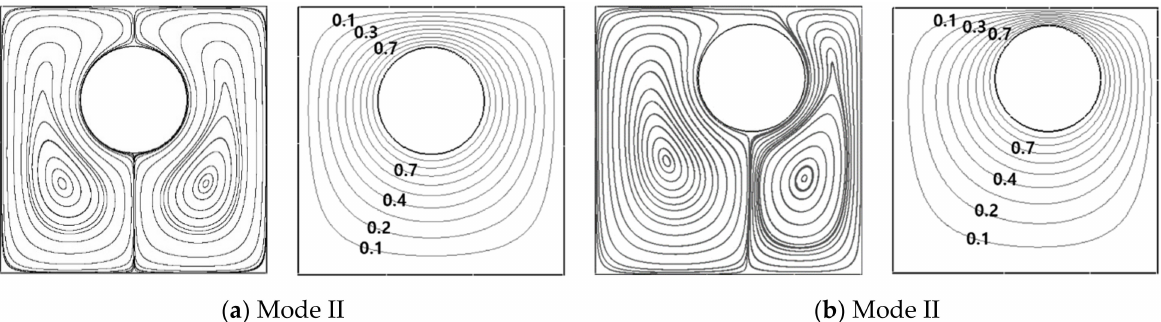
Figure 6. Streamlines (left column) and isotherms (right column) at ( a ) ( r = 0.15 L , θ = 90 ◦ ), ( b ) ( r = 0.25 L , θ = 70 ◦ ) for Ra = 10 3